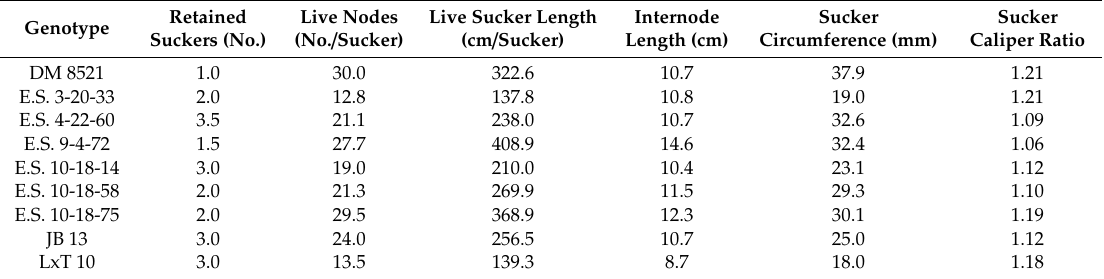
Table A2. Sucker metrics for unreplicated cold-hardy grapevine genotypes (two-vine plot / genotype) trained during the 2019 growing season at the NDSU Horticulture Research Farm near Absaraka, ND,